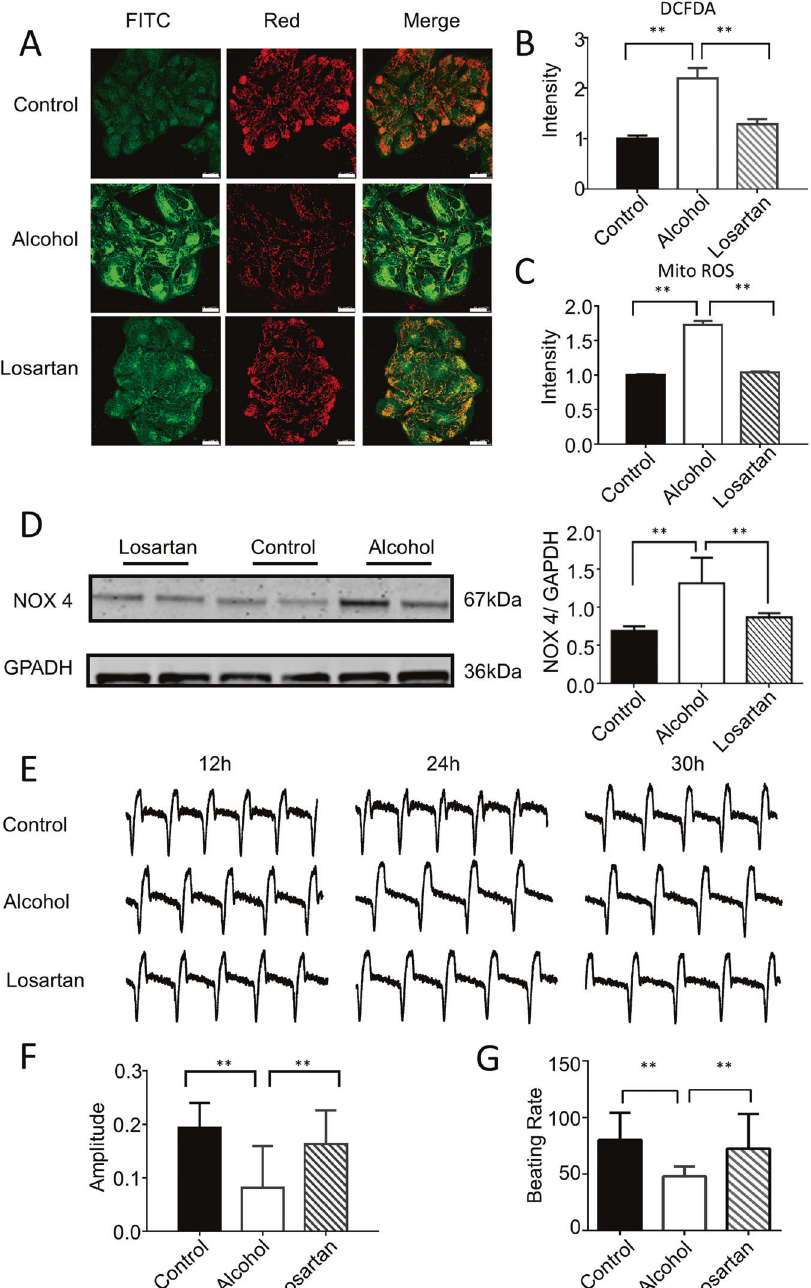
Fig. 5 Blocking AT1R prevents the electrophysiological abnormalities and cardiac oxidative stress in hiPSC-CMs models of ACM. A Representative immuno fl uorescence images of JC-1 labeling showed a reduction in green fl uorescence intensity after losartan administration compared with that after alcohol treatment ( n = 20). Scale bar = 25 μ m. B Representative immuno fl uorescence images of CM-H2DCFDA showed that losartan restored the level of mitochondrial oxidative stress induced by 100-mM alcohol. ( n = 10) C Representative immuno fl uorescence images of Texas red labeling showed that losartan restored the level of the oxidative stress induced by 100-mM alcohol. ( n = 10) D Western blotting and quantitative statistics showed that losartan restored the protein expression level of NOX4 induced by 100-mM alcohol ( n = 5). E – G RTCA for dynamically monitoring cell index waveform, amplitude and beat frequency showed that losartan restored the electrophysiological disturbance of hiPSC-CMs induced by 100 mM alcohol [ F ( n = 39); G ( n = 41)]. Results are presented as means ± standard error of the mean (** P < 0.01; two-sided Student ’ s t -test or one-way analysis of Western blotting which was blocked with 5% albumin bovine at room temperature for 1 h Proteins from hiPSC-CMs were extracted using a Protein Extraction Kit and then incubated at 4 °C overnight with the primary antibodies GAPDH, (Promega, USA). The protein concentration of the supernatant was AT1R, and NOX4 (Santa Cruz, USA) and then with IR dye-conjugated measured using the BCA method. Then, 20 µg protein was separated on secondary antibodies (Rockland Immunochemical, USA) for 1 h at room 10% SDS-PAGE and transferred to PVDF membrane at 300 mA for 90 min, temperature. GAPDH was used as an internal control. Blots were exposed